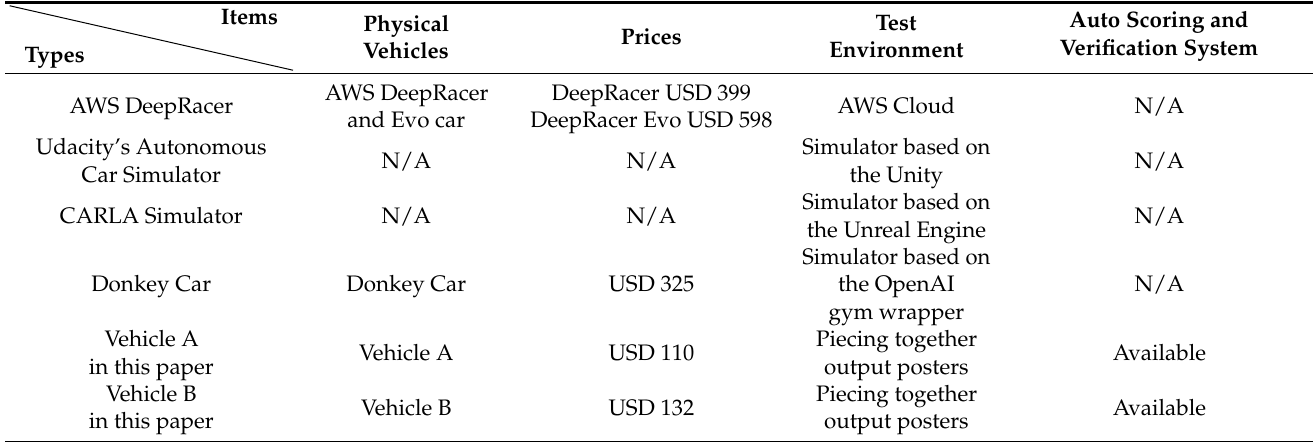
Table 4. Comparison results of the items for different